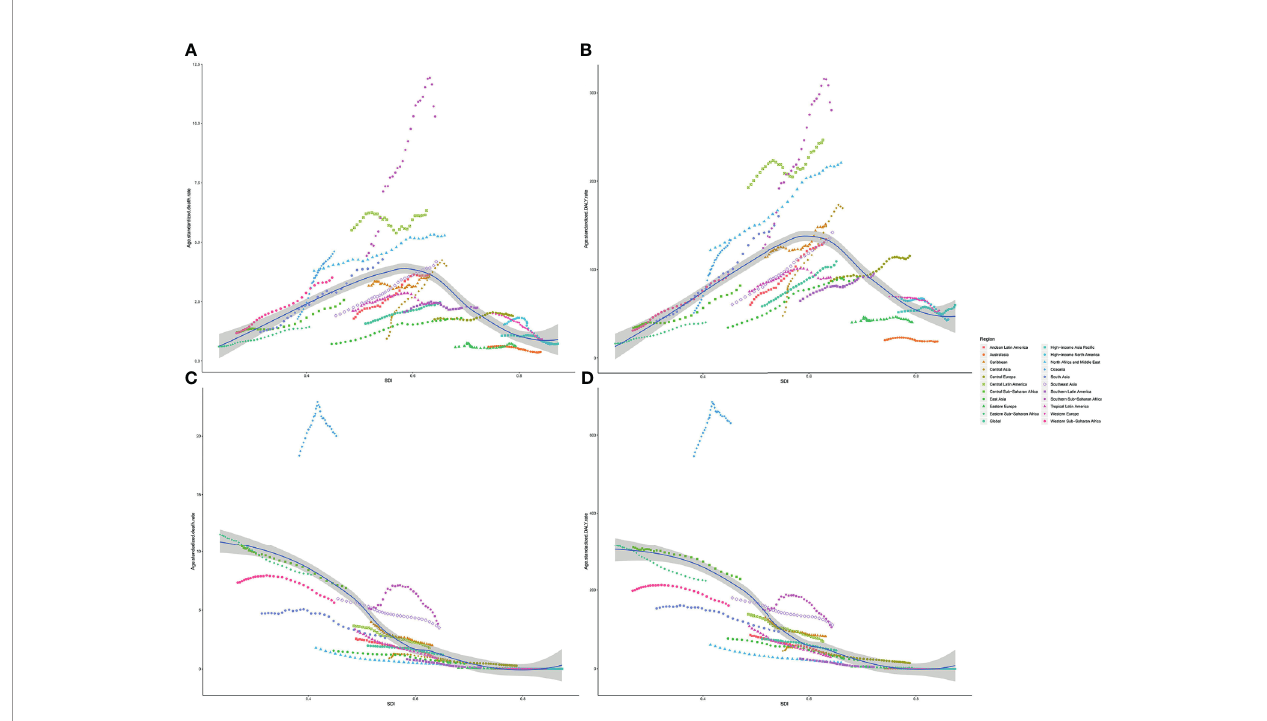
FIGURE 5 | Association between type 2 diabetes mellitus burden attributable to particulate matter pollution and SDI among 21 regions. (A) ASDR of type 2 diabetes mellitus attributable to APMP; (B) Age-standardized DALY rate of type 2 diabetes mellitus attributable to APMP; (C) ASDR of type 2 diabetes mellitus attributable to HAP; (D) Age-standardized DALY rates of type 2 diabetes mellitus attributable to HAP. ASDR, age-standardized death rate; DALY, disability-adjusted life-year; SDI, socio-demographic index; APMP, ambient particulate matter pollution; HAP, household air